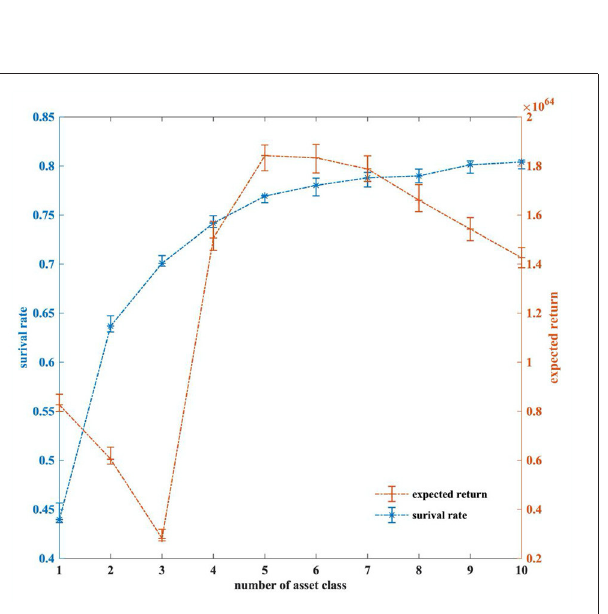
FIGURE 8 | The expected return and survival rate of the bank under different asset